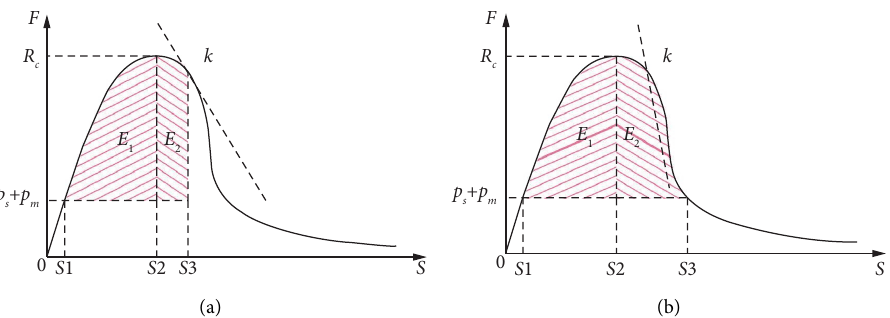
Figure 10: Stress-displacement relationship curve of rock burst induced by the coal mine earthquake. (a) Shock instability. (b) Static